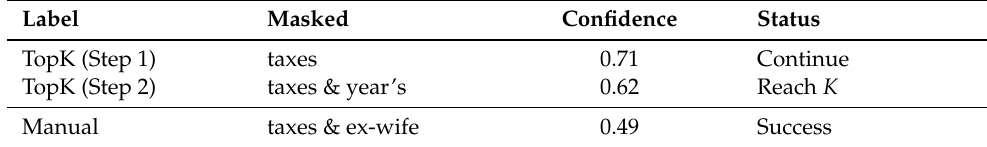
Table 4. Example of TopK. In this case, K is set to 2 and TopK fails to generate an adversarial example, while the successful one exists beyond the TopK search.